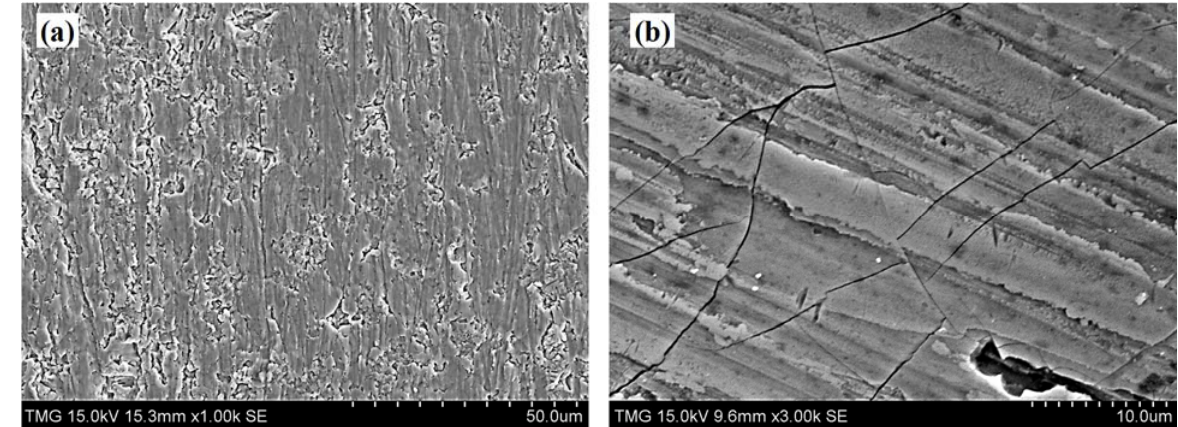
Figure 20. SEM micrograph of ( a ) non-treated Ti64 specimen; and ( b ) DR-treated Ti64 specimen during stage 1 of the LIE